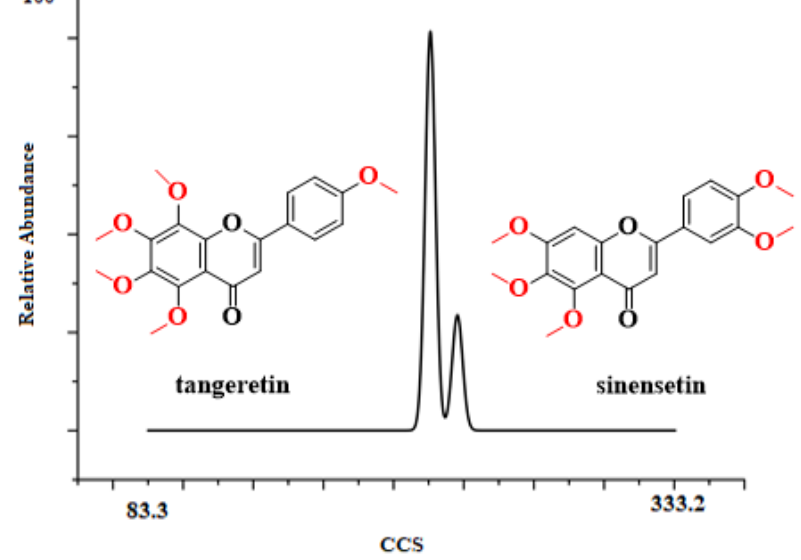
Figure 2. Ion mobility diagram of tangeretin and sinensetin.